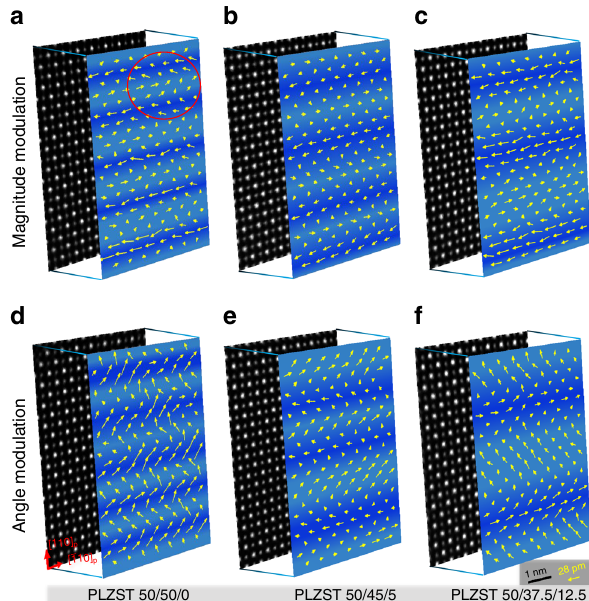
Fig. 2 Polarization mapping based on cations displacement in PLZST system. a – c Magnitude modulation mode and ( d – f ) angle modulation mode of dipoles ordering con fi gurations (front) as revealed from the atomic-scale HAADF images (back) acquired along the [001] direction. The dark/light- blue backgrounds highlight the switch of polarization con fi guration. The full view of the corresponding HAADF images are presented in Supplementary Fig. 2. The red circled area in ( a ) shows the dipoles ordering con fi guration being nearly consistent with the one in PbZrO 3